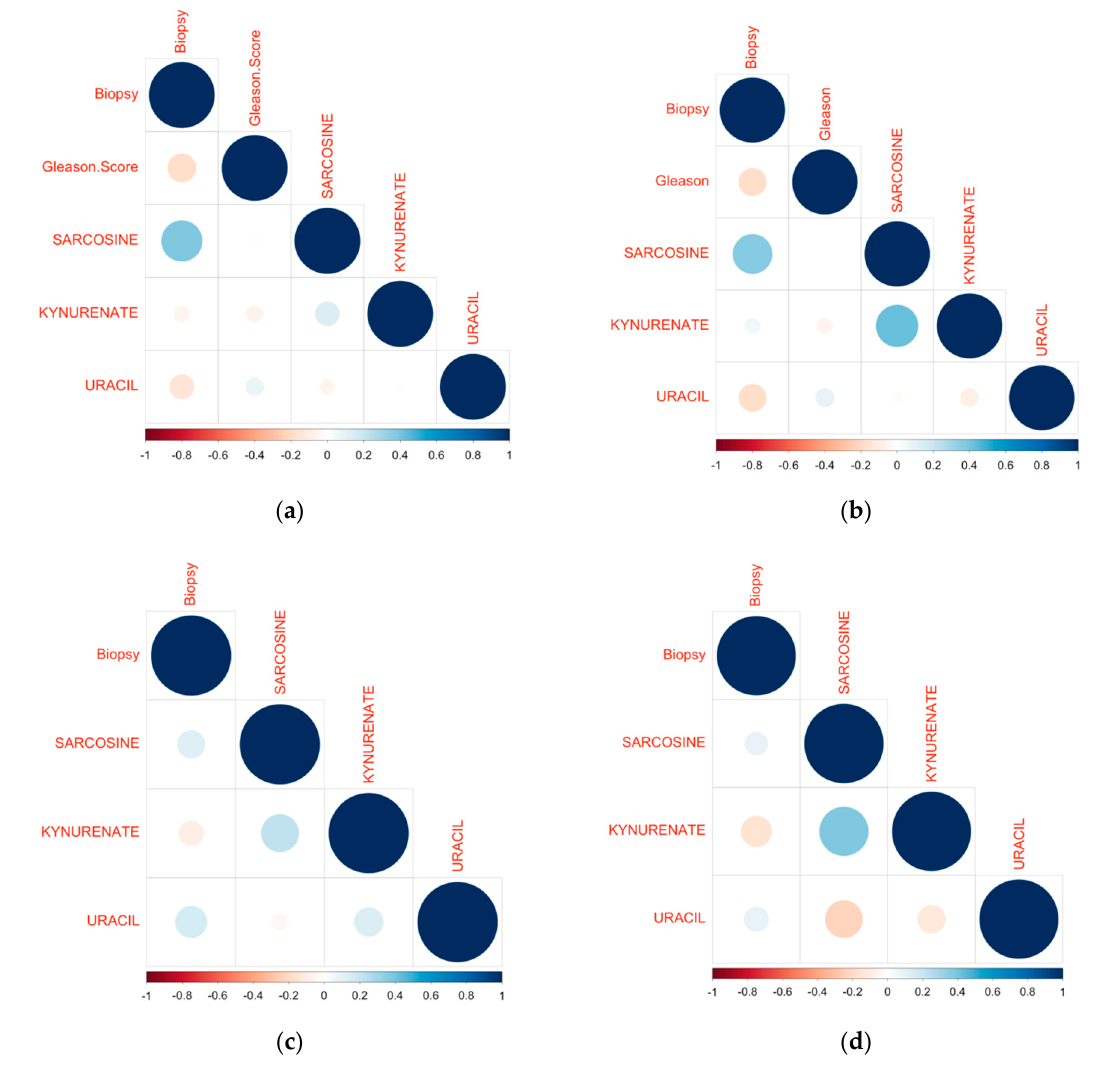
Figure 4. Pearson correlation heatmap of histopathologic data and measured metabolites in urine samples of group B patients ( a ) positive in UGBP, pre-PM; ( b ) positive in UGBP, post-PM; ( c ) negative in UGBP pre-PM; and ( d ) negative in UGBP post-PM patients.